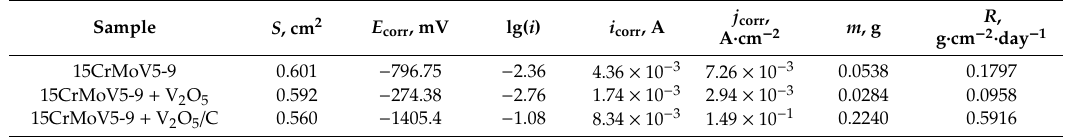
Table 3. Results of potentiostatic tests.